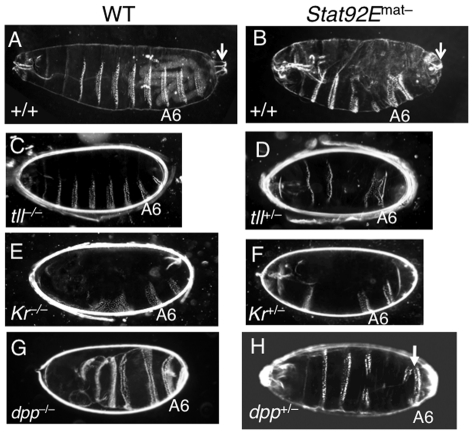
Effects of lacking Stat92E on cuticle morphology of
embryos.Dark-field images of larval cuticles of different genotypes are shown,
with anterior to the left. The position of the sixth abdominal denticle
belt is marked as A6. (A) A ventral view of a wild-type larval cuticle,
with eight abdominal denticle belts seen in the ventral region, spanning
<50% of the body circumference. The arrow points to the
Filzkörper, a terminal element. (B)
Stat92Emat– cuticle exhibits
defects in central elements (A4, 5) and minor defects in the posterior
region, but does not show overt D/V polarity defects. Note that the
Filzkörper is present (arrow). (C)
tll–/– embryos are
missing posterior terminal structures (A8 and the Filzkörper). (D)
Stat92Emat–;
tll+/– embryos lack
posterior terminal structures (A7/8 and the Filzkörper), similar to
tll–/– embryos. (E)
Kr–/– embryos exhibit
anterior defects, lacking or having fused A1–5 ventral deticle
bands. (F) Stat92Emat–;
Kr+/– embryos are missing
many anterior denticle bands, reminiscent of
Kr–/– embryos. (G)
dpp–/– larvae are
ventralized, with denticle belts around the whole body circumference.
(H) A portion of State92Emat–;
dpp+/– larvae are
partially ventralized, with posterior denticle belts (usually A6; arrow)
extended to the dorsal side, encompassing 80% of the body
circumference.